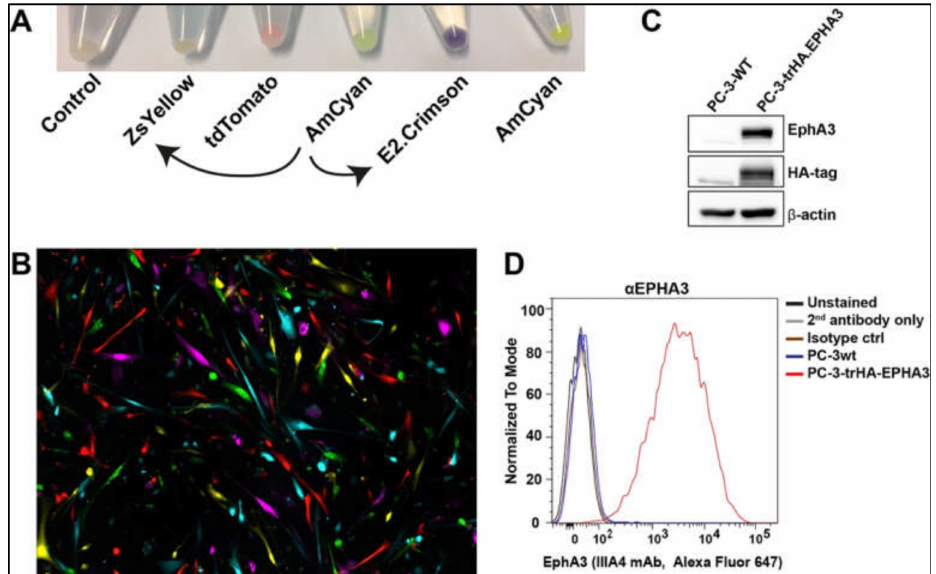
Figure 5. Newly designed lentiviral particles are used in cell tracing and protein labelling ( A ). Lentivi- ral particles allowed expression of E2. Crimson and ZsYellow fluorescent proteins. Curved arrows indicate that pLVX-E2. Crimson-C1 and pLVX-ZsYellow-C1 lentiviral plasmids were prepared by using pLVX-AmCyan1-C1 as a vector backbone ( B ). Chimeric expression of five different fluorescent proteins in tumour cells that are infected with lentiviral particles ( C ). Lentiviral particles allowed expression of HA-tagged EPHA3 protein in PC-3 cells. The left lane is wild type (wt) PC-3 cells with undetectable EPHA3 and HA-tag expression. The right lane is PC-3 cells infected with HA.EPHA3 lentiviral particles. β -actin was used as a loading control ( D ). Cell membrane localisation of HA- tagged EPHA3 protein was tested by FACS analysis of nonpermeabilized cells. EPHA3 antibody successfully detected the recombinant EPHA3